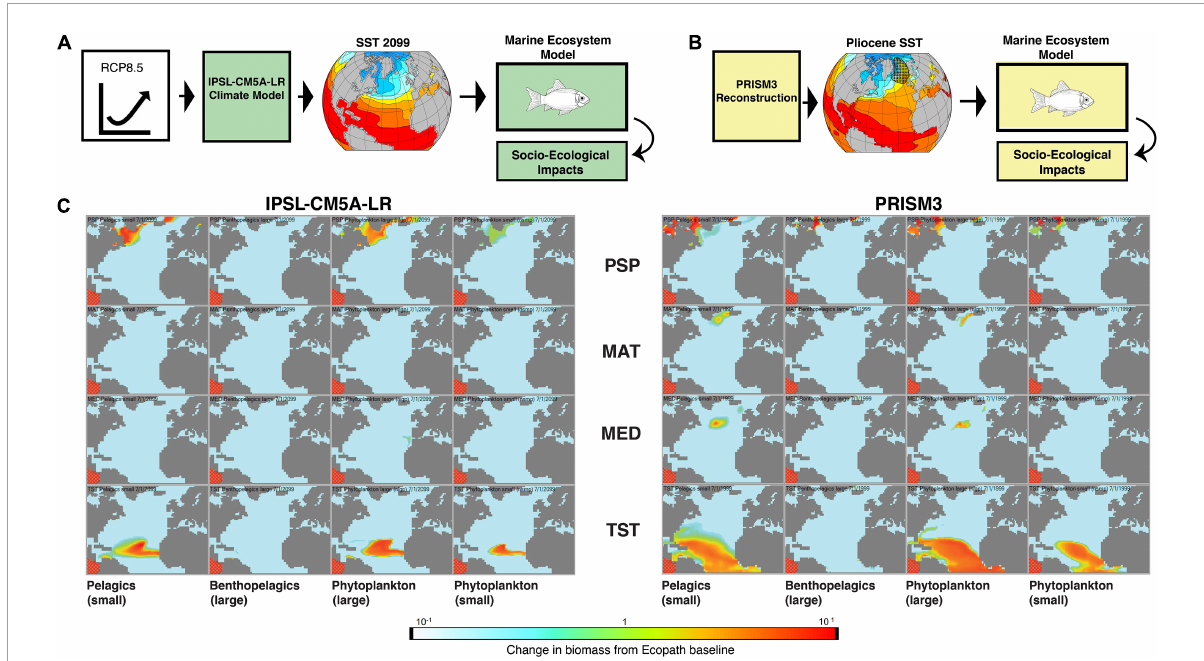
FIGURE2 Conceptual framework for application of paleoclimate data to conservation management. (A) A high greenhouse gas emissions trajectory (RCP8.5) is used to drive a climate model (IPSL-CM5A-LR) to produce future SSTs. These climate model-derived SSTs are in turn used to drive a marine ecosystem model (see text for description) which provides information on potential socio-ecological impacts of future climate. (B) The Late Pliocene PRISM3 multiproxy SST reconstruction is used to drive the same marine ecological model, providing an alternative scenario for socioecological impacts of a potential future climate. Hatched pattern in northeast North Atlantic in panel (B) is a region where paleoclimate models tend to exhibit lower SST than those estimated by multiple proxies. (C) Example of relative biomass changes in the North Atlantic produced by the marine ecosystem model. IPSL climate model-derived (left) and PRISM proxy-driven (right) simulations. The columns represent selected functional groups: small pelagics; large benthopelagics; large phytoplankton; and small phytoplankton. The rows from top to bottom comprise the four model subregions: Polar-Subpolar (PSP); Mid-Atlantic (MAT); Mediterranean (MED); and Tropical-Subtropical